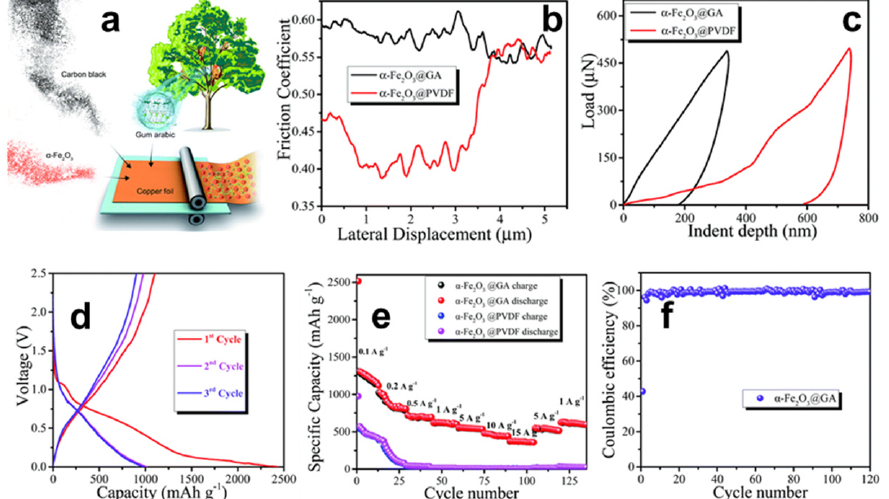
Figure 6. ( a ) Schematic illustration of the electrode fabrication process with GA binder. ( b ) Friction coefficient and ( c ) load-displacement curves for α -Fe 2 O 3 combined with PVdF and GA. ( d ) Charge and discharge profile of α -Fe 2 O 3 combined with GA in the first, second, and third cycle at a current density of 0.2 A g − 1 . ( e ) Rate capabilities test of α -Fe 2 O 3 combined with PVdF and GA. ( f ) Coulombic efficiency of α -Fe 2 O 3 combined with GA [70].